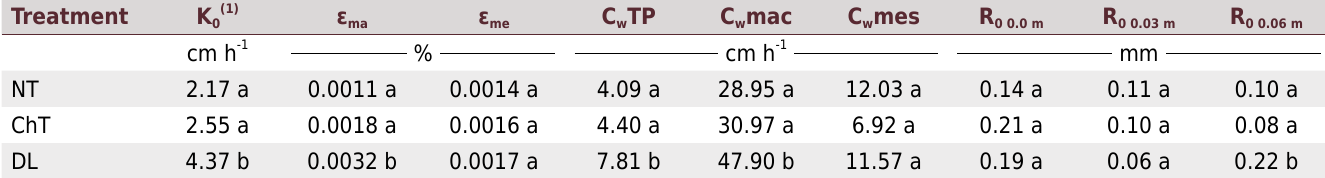
Table 1. Values of field saturated hydraulic conductivity (K 0 ), water-conducting macro and mesoporosity (ε ma , and ε me , respectively), pore continuity indexes based on water flux for total porosity, macroporosity, and mesoporosity (C w TP, C w mac, and C w mes, respectively), and flow-weighted mean pore radius corresponding to applied pressure heads of 0.00. 0.03, and 0.06 m (R 0 0.00 m , R 0 0.03 m , and R 0 0.06 m , respectively) for the different